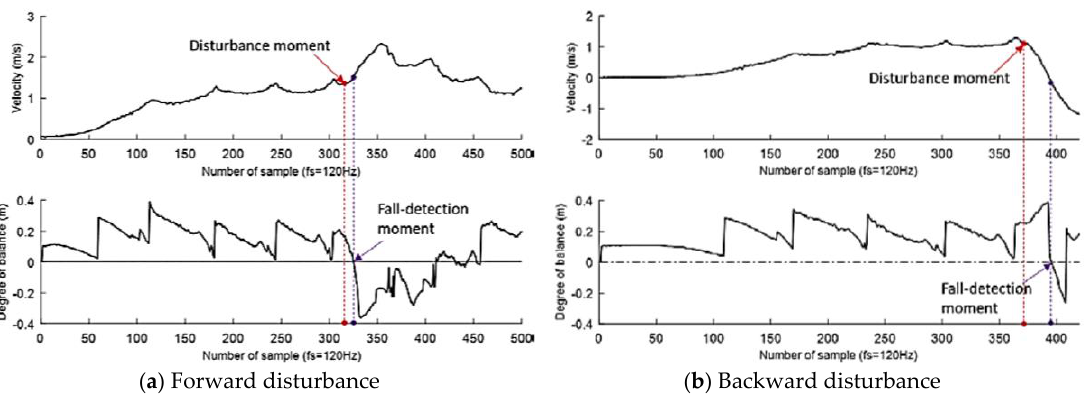
Figure 7. The degree of single step balance during forward walking.